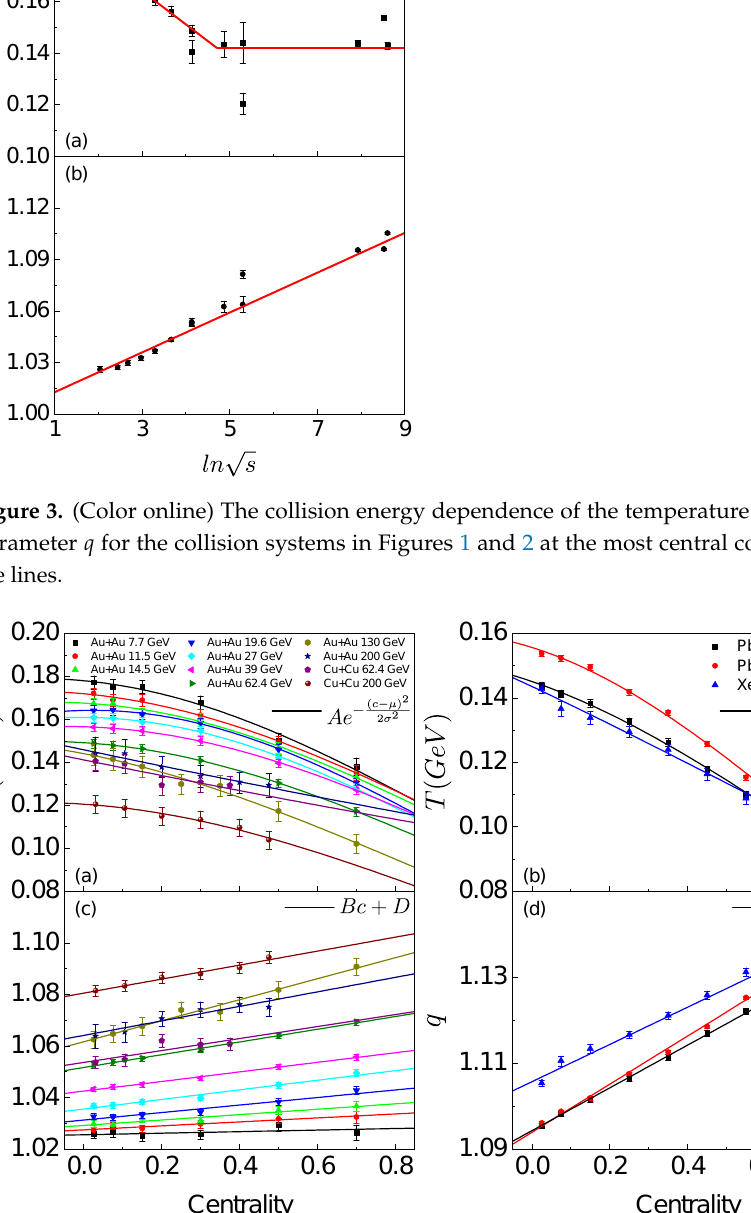
√ s NN = 62.4, 200 GeV, √ s NN = 5.44 TeV. The curves in